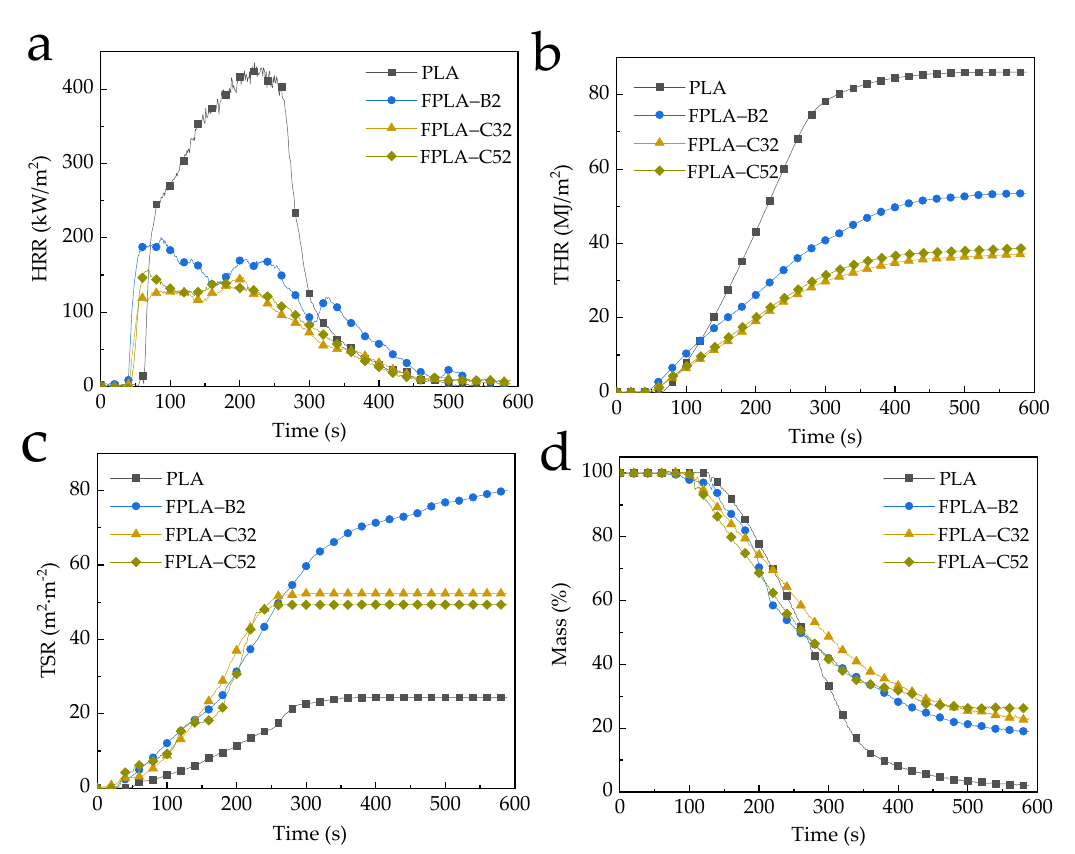
Figure 11. Images of carbon residues of PLA and FPLA composites after CONE tests: ( a 1 ,a 2 ) PLA, ( b 1 ,b 2 ) FPLA-B2, ( c 1 ,c 2 ) FPLA-C32, and ( d 1 ,d 2 ) FPLA-C52.